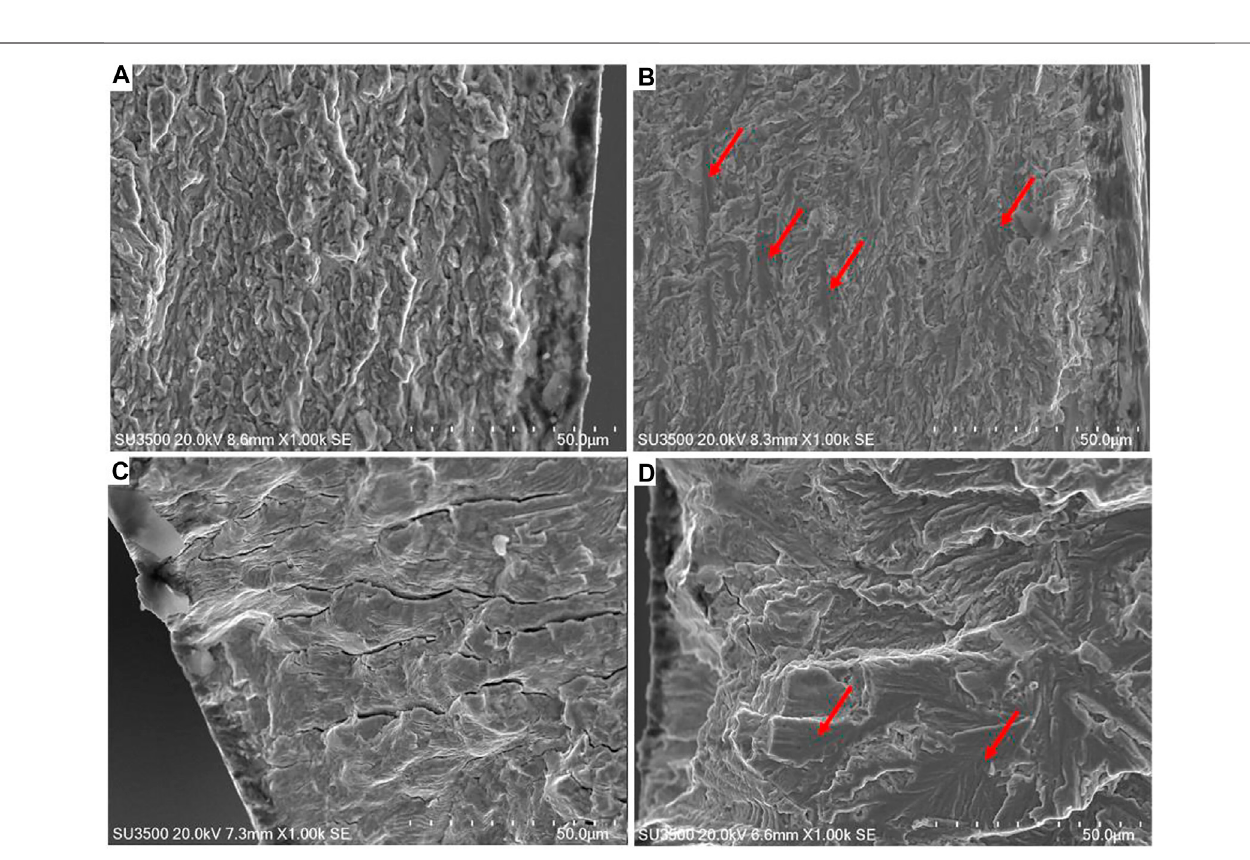
Frontiers in Materials |